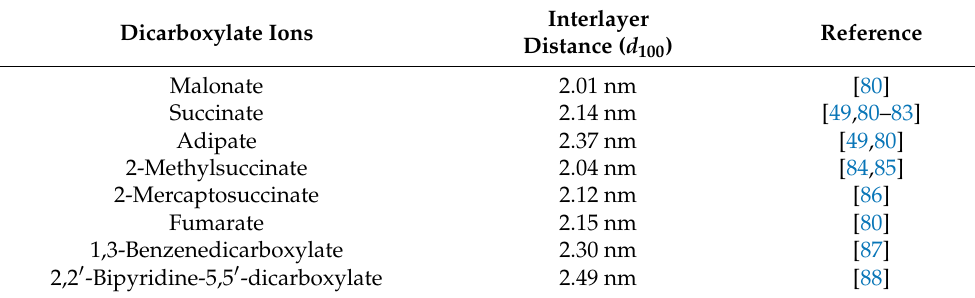
Table 1. Interlayer distances of OCPC hybridized with various dicarboxylate